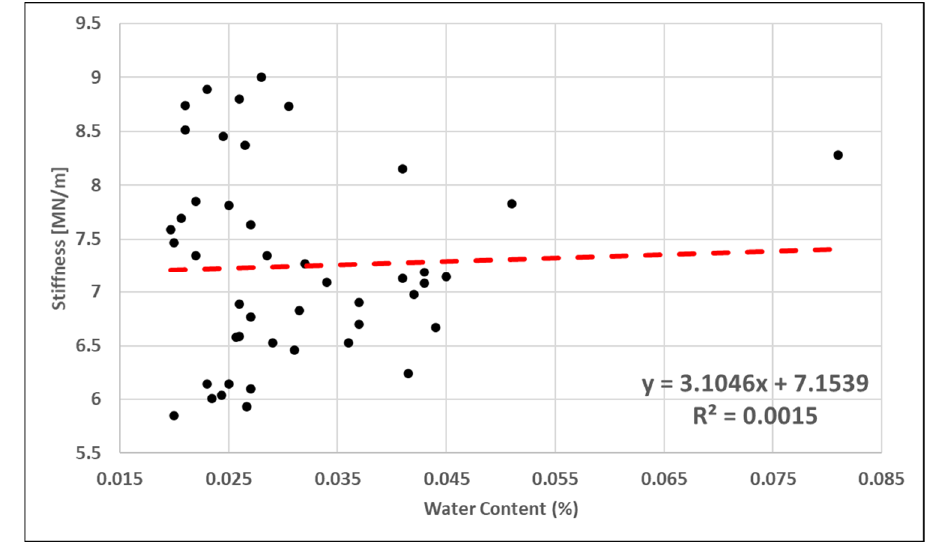
Figure 8. Plot of all the samples Stiffness [MN/m] verses Water Content [%].